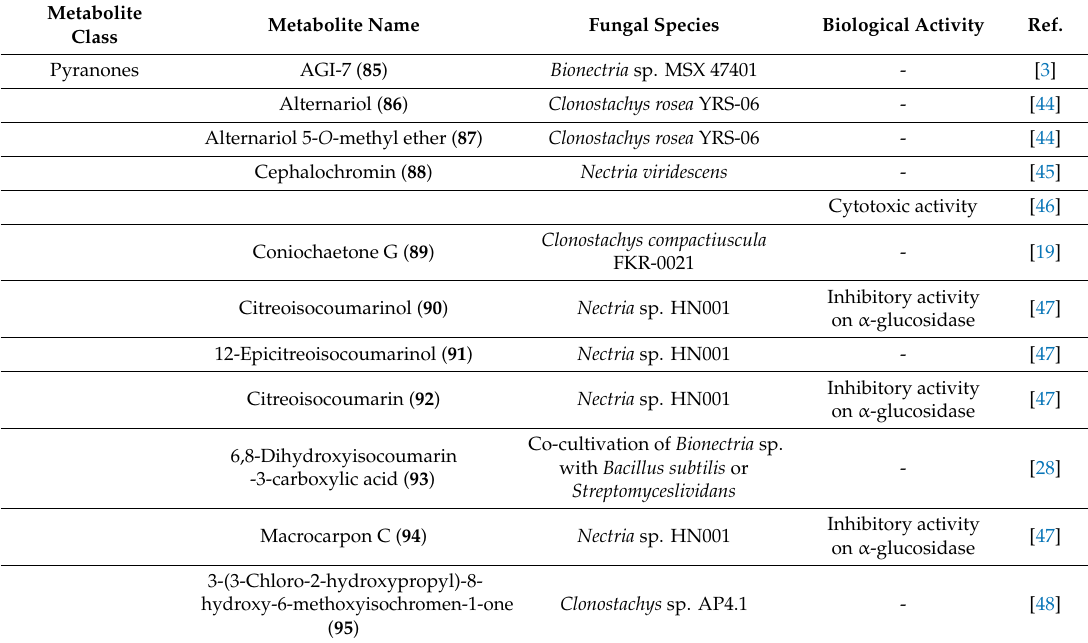
Table 2. Polyketides in Clonostachys fungi and their biological